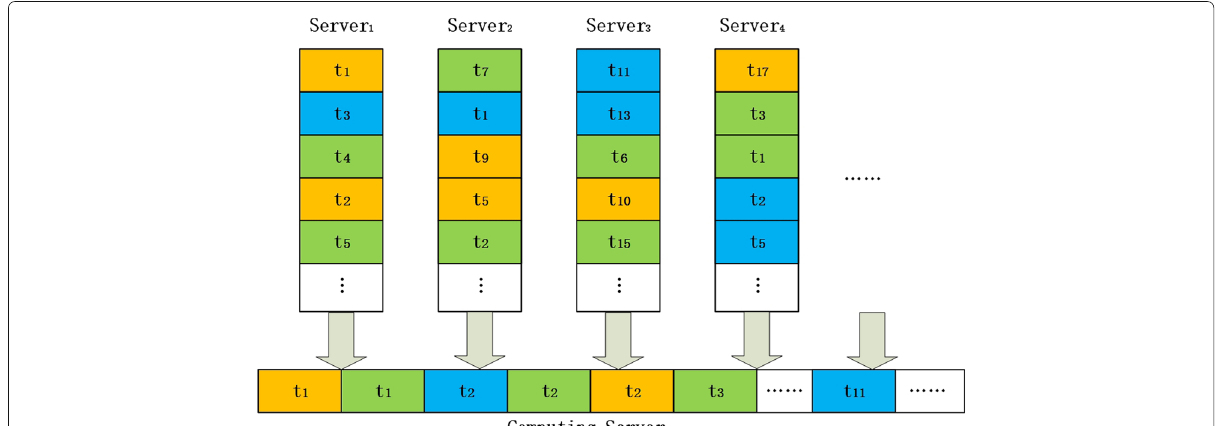
Fig. 2 Preprocessing of sliding time window algorithm